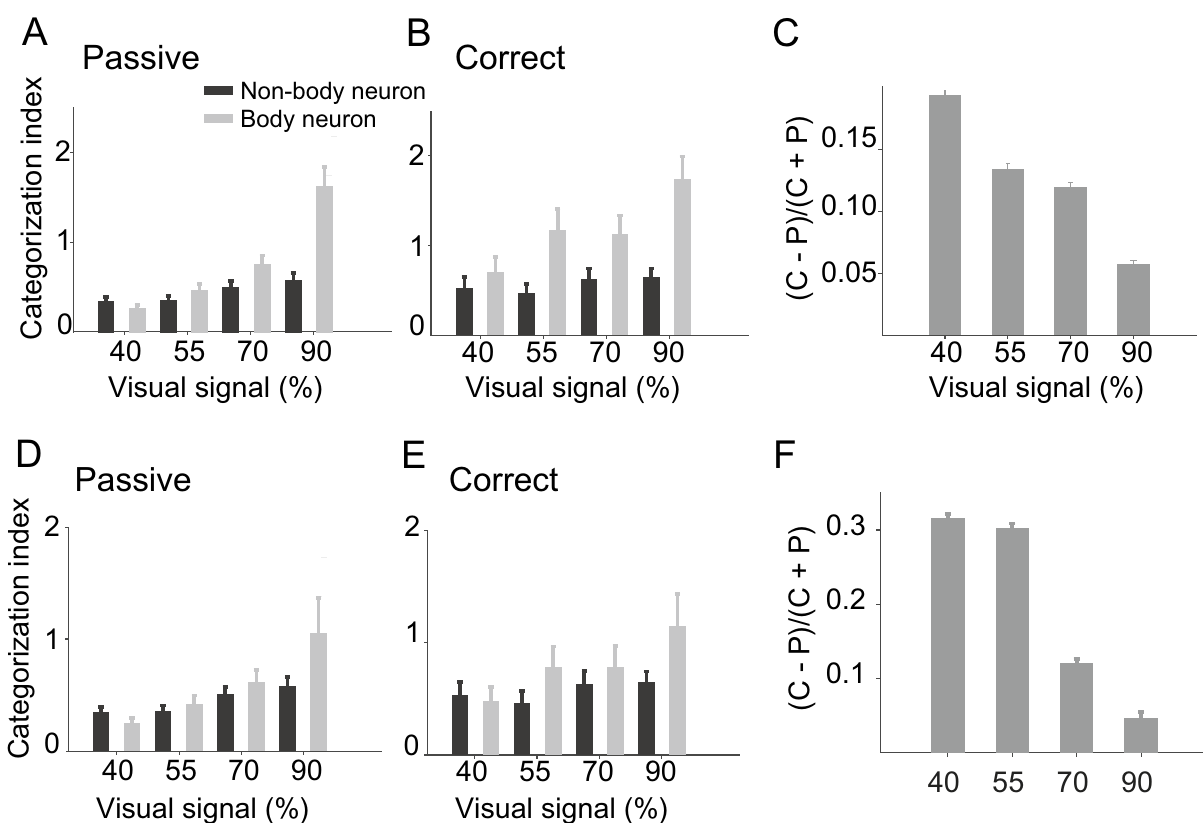
Figure 5. Comparison of category information conveyed by the body and non-body neurons. Mean category information from 150 to 350 ms after stimulus onset in passive ( A ) and correct ( B ) trials are shown for selective (body and non-body) and non-selective neurons. ( C ) Category information in the correct trials compared to passive trials in non-body neurons. The mean absolute value of SI in both body and non-body group was equalized. Mean category information from 150 to 350 ms after stimulus onset in passive ( D ) and correct ( E ) trials are shown for body and non-body neurons. ( F ) The category information in the correct, compared to the passive, trials in SI-matched body neurons. Error bars represent the STD of bootstrap